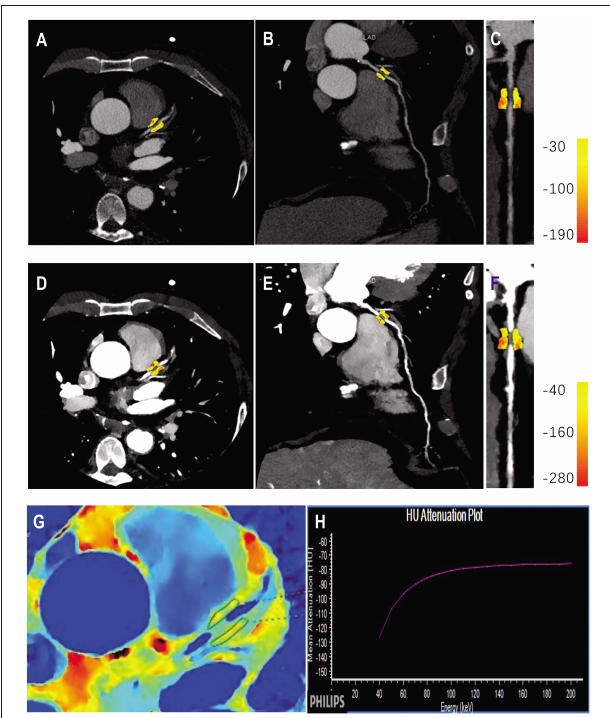
FIGURE 2 | Quantitative PCAT analysis in a case example of a 56-years old male patient with significant coronary artery stenosis (severe stenosis in proximal LAD). Axial view and the corresponding curved multiplane and straightened view of PCAT of the proximal LAD in the conventional 120 kVp (A–C) and 40 keV VMI (D–F) . (G,H) Represented the corresponding panels of Eff-Z imaging and spectral attenuation curve, respectively. LAD, left anterior descending artery; VMI, virtual monochromatic